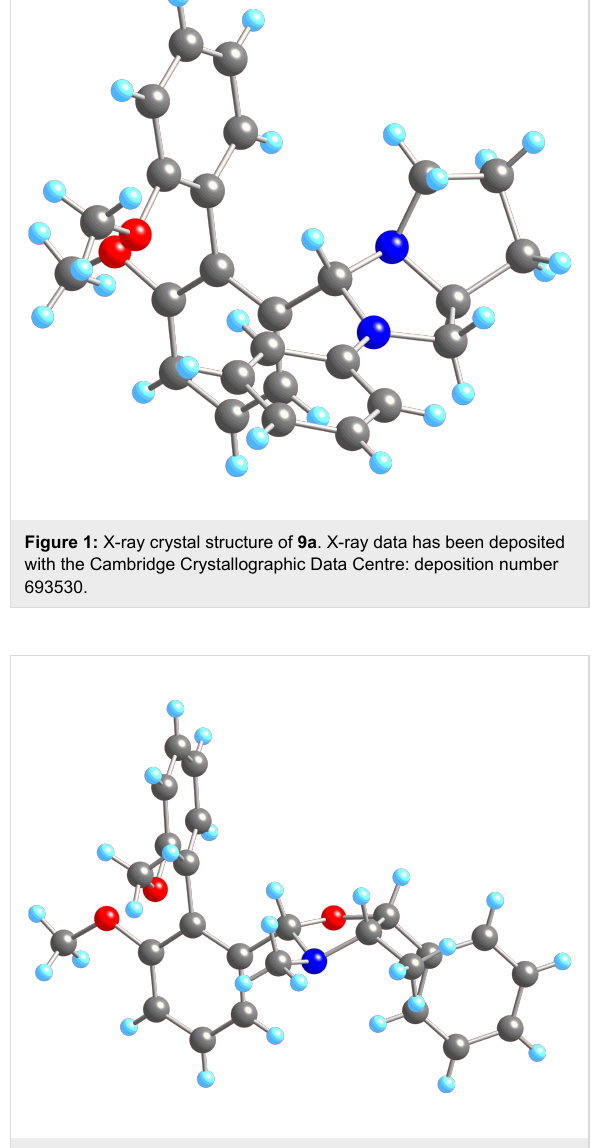
Figure 2: X-ray crystal structure of 10a . X-ray data has been depos- ited with the Cambridge Crystallographic Data Centre: deposition number 693529.